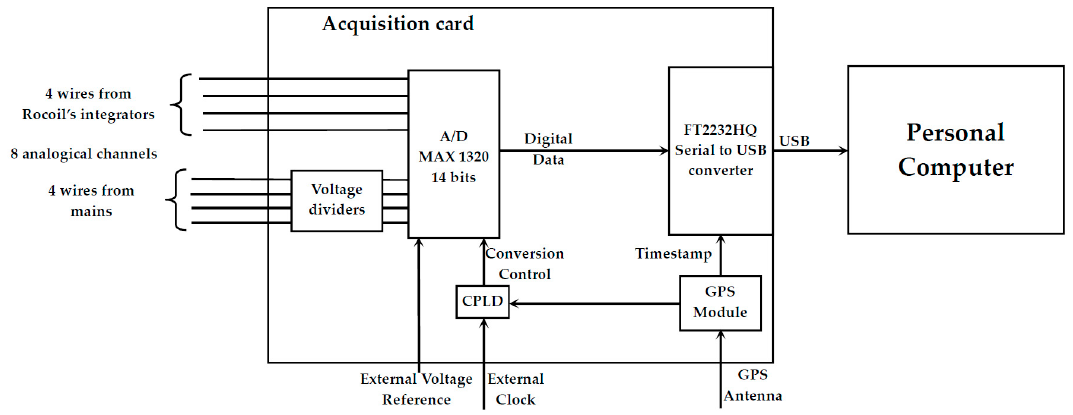
Figure 2. Block scheme of the architecture of the acquisition card. CPLD Complex Programmable Logic Device,